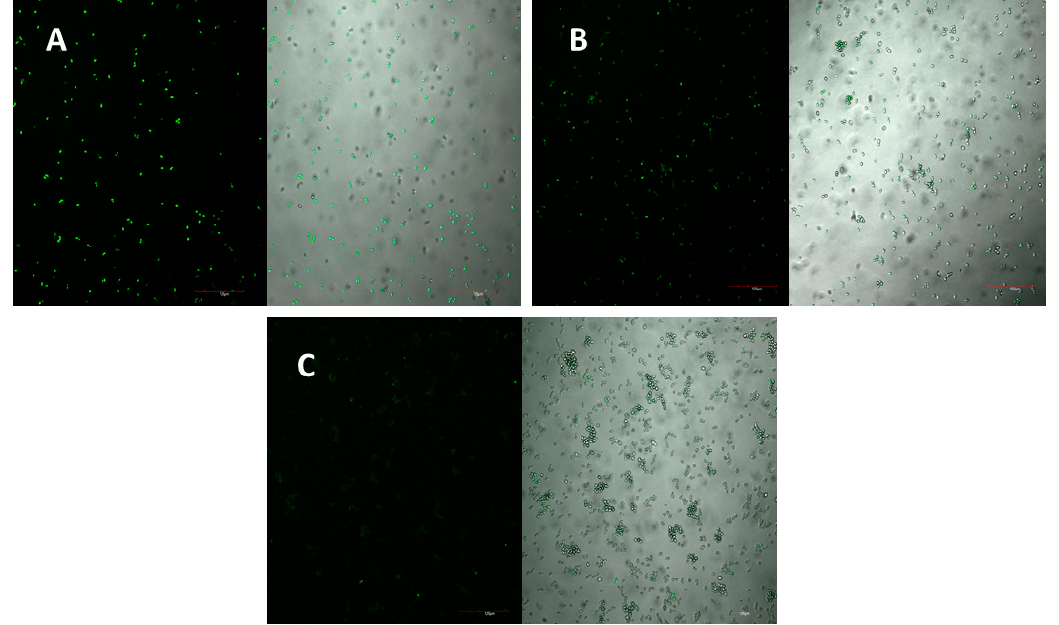
Figure 5. The overproduction of reactive oxygen species (ROS) generated by the presence of the peptide at the difference concentrations of ( A ) 400 µ g/mL, ( B ) 200 µ g/mL and ( C ) 100 µ g/mL. A reduction in ROS overproduction is observed as the concentration of D-lp1 is reduced.